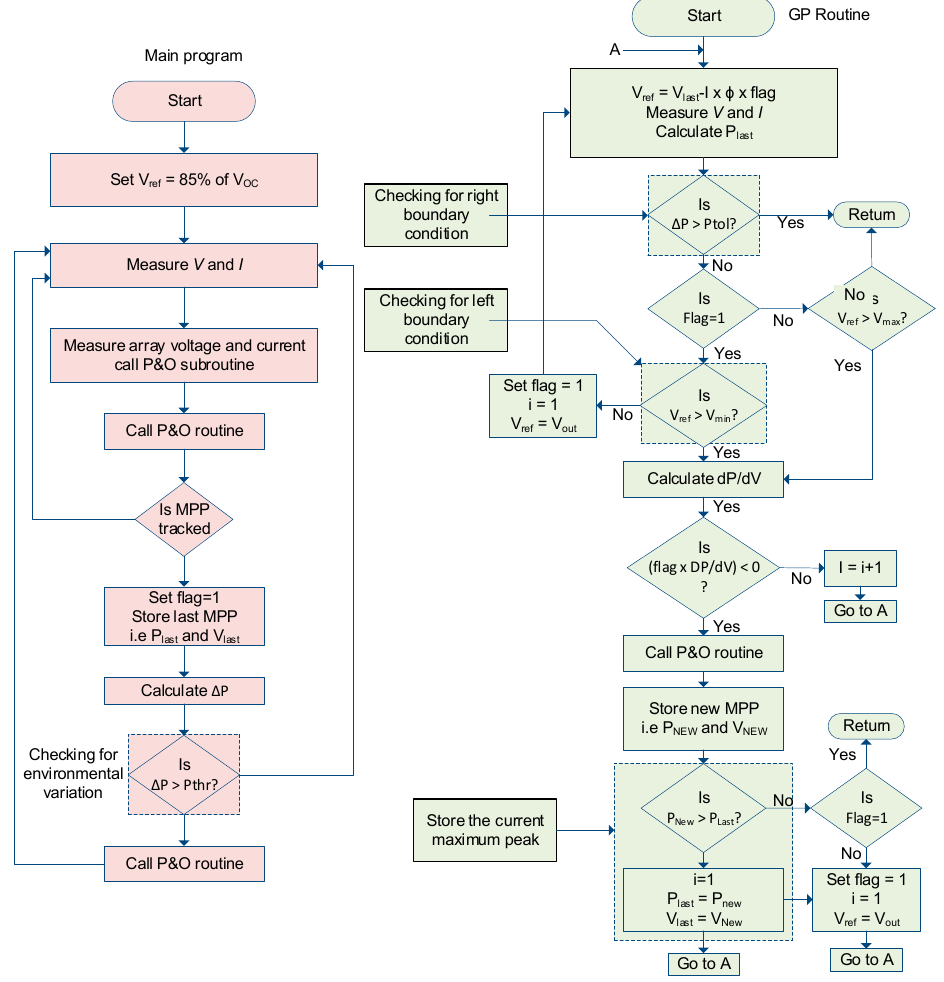
Figure 8. Flow chart of the two-mode modified perturb and observe (MP&O) method.